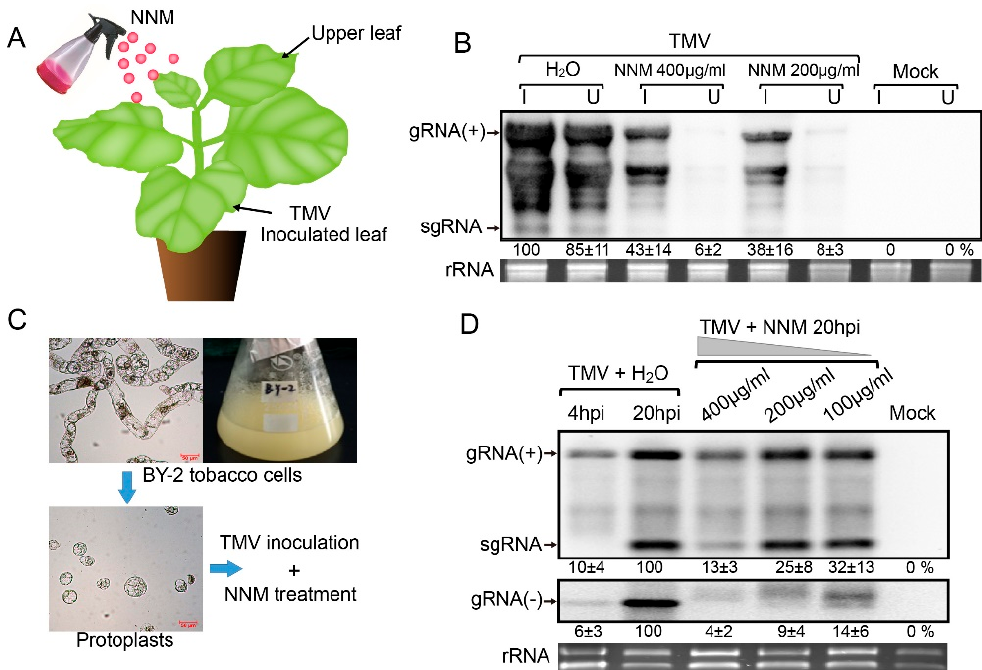
Figure 1. E ff ects of Ningnanmycin (NNM) treatment on tobacco mosaic virus (TMV)-inoculated Nicotiana benthamiana and BY-2 protoplasts. ( A ) Schematic representation of TMV-inoculated leaves (I) and the un-inoculated upper leaves (U) of N. benthamiana with the treatment of distilled H 2 O, 100 µ g / mL and 50 µ g / mL NNM at 7 dpi. ( B ) Northern blot analysis of the accumulation of TMV RNA from the inoculated leaves and upper leaves and relative accumulation of genomic RNA (gRNA) are shown. The ribosomal RNA (rRNA) is shown below the northern blots as a loading control. ( C ) Schematic representation of NNM treatment on TMV-inoculated BY-2 protoplasts. ( D ) RNA accumulations of TMV in BY-2 protoplasts under various concentrations of NNM treatment and relative accumulation of positive- and negative-strand gRNA are shown.